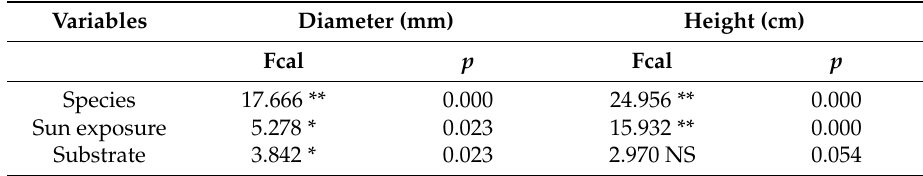
Table 2. Analysis of variance for growth variables.